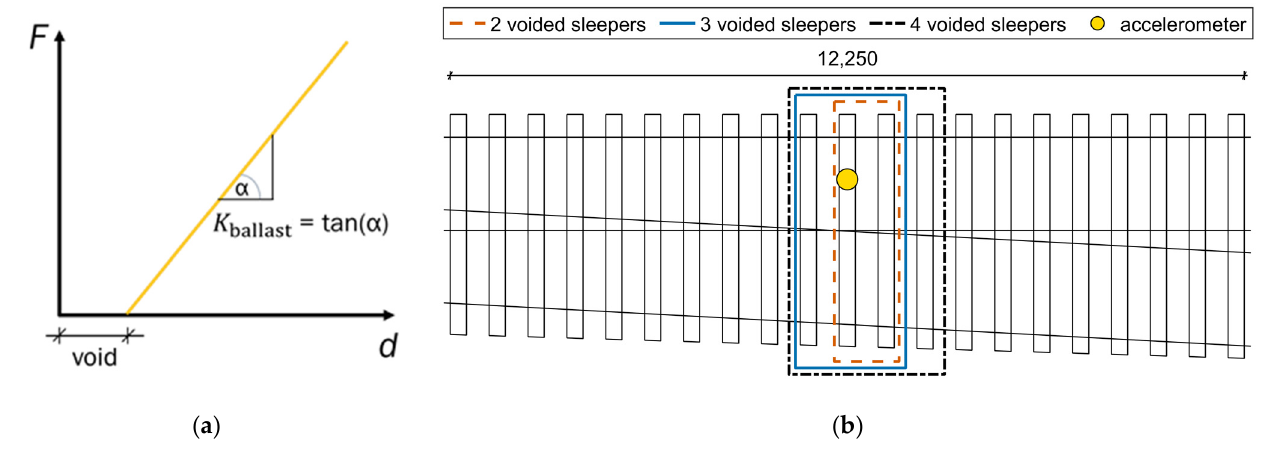
Figure 8. ( a ) Bi-linear force-displacement ( F versus d ) function for ballast force per meter sleeper length used for simulation of a voided sleeper. ( b ) Technical drawing for 12.25 meters of crossing panel marking three alternatives for voided sleepers in the MBS model (three cases with 2, 3, or 4 consecutive voided sleepers in the crossing transition).